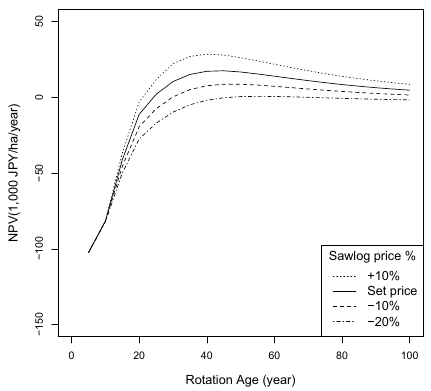
Figure 5. The relationship between the saw log price and the NPV for saw log production at a plantation density of 3000